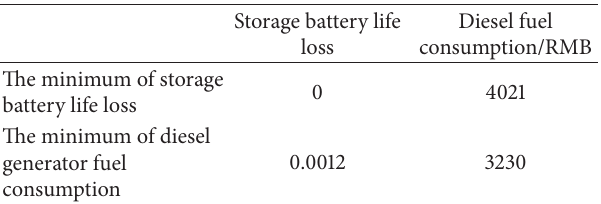
Table 2: The extreme solution of Pareto optimal concentration considering the effect of auxiliary power